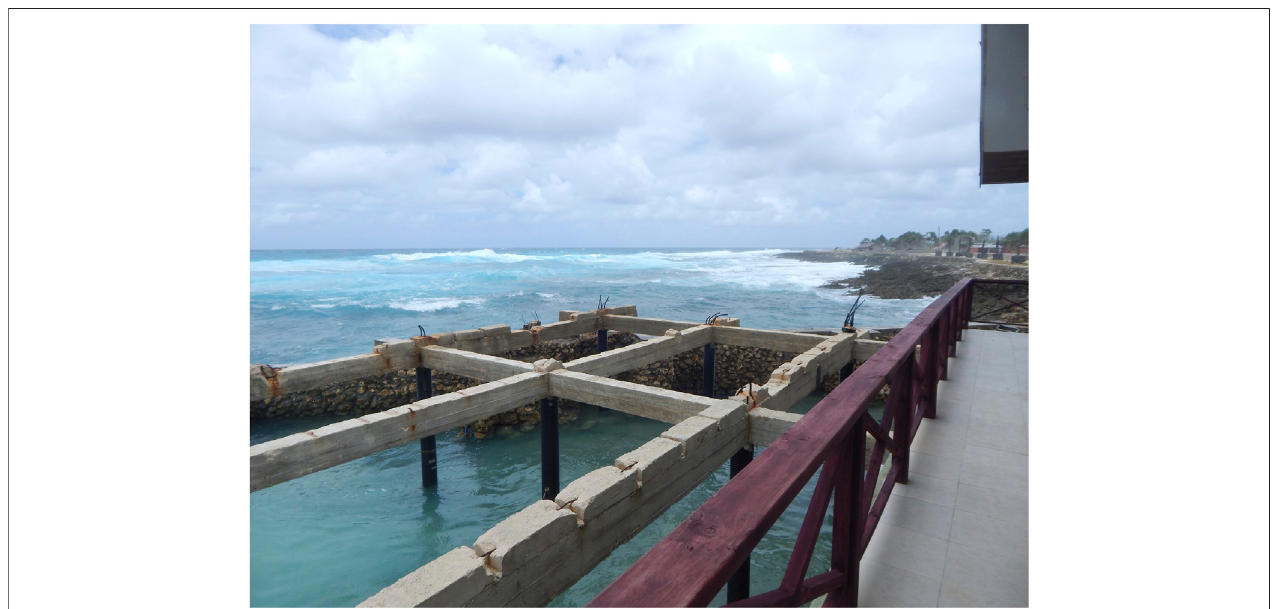
FIGURE 2 | Cyclone Pam destroyed the terrace of this beachside restaurant on Efate Island. Source: Author ’ s own.